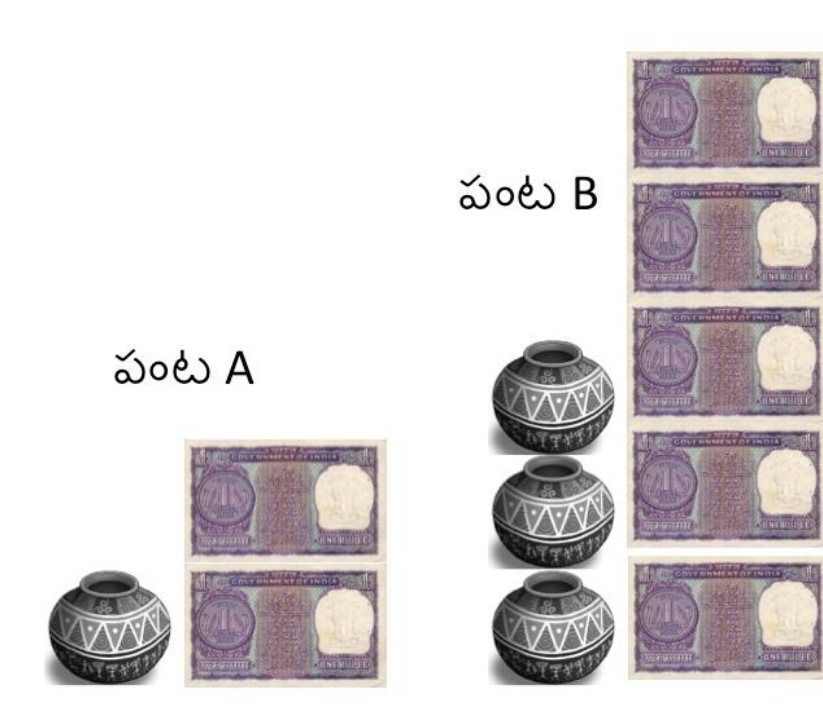
Figure 1. Crop A/B